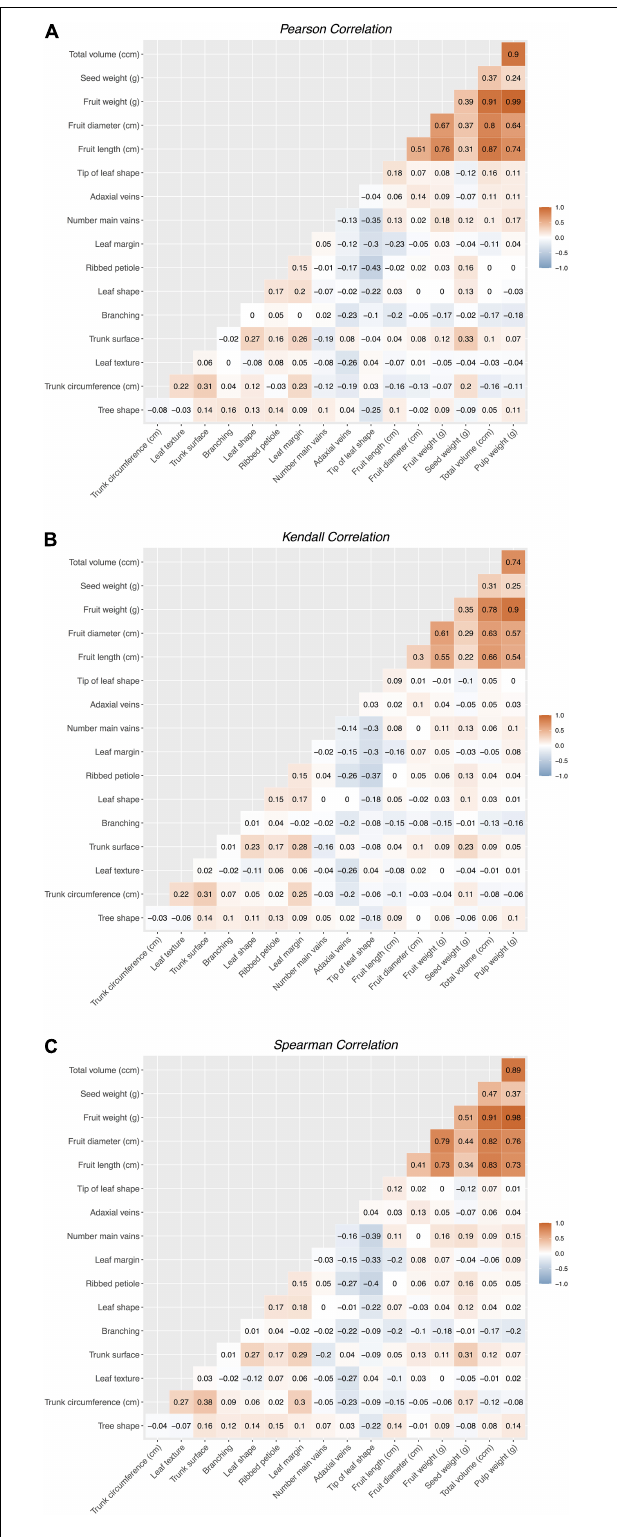
FIGURE 1 | Pearson (A) , Spearman (B) , and Kendall (C) correlation matrices among studied traits in avocado “criollo” “plus trees.” For details on the measured traits please refer to Table 1 and Supplementary Table 2